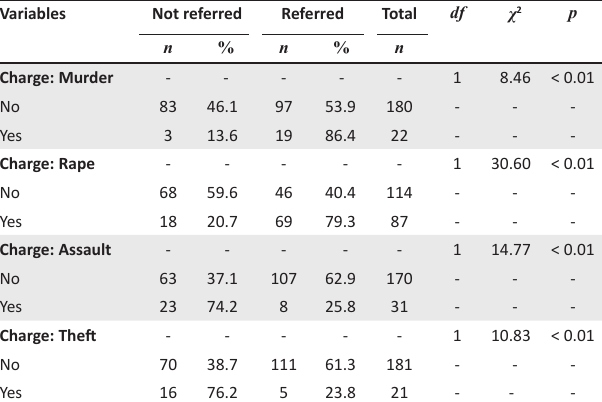
TABLE 4: Forensic profile comparison between group referred to Fort Napier Hospital and group not referred. Variables